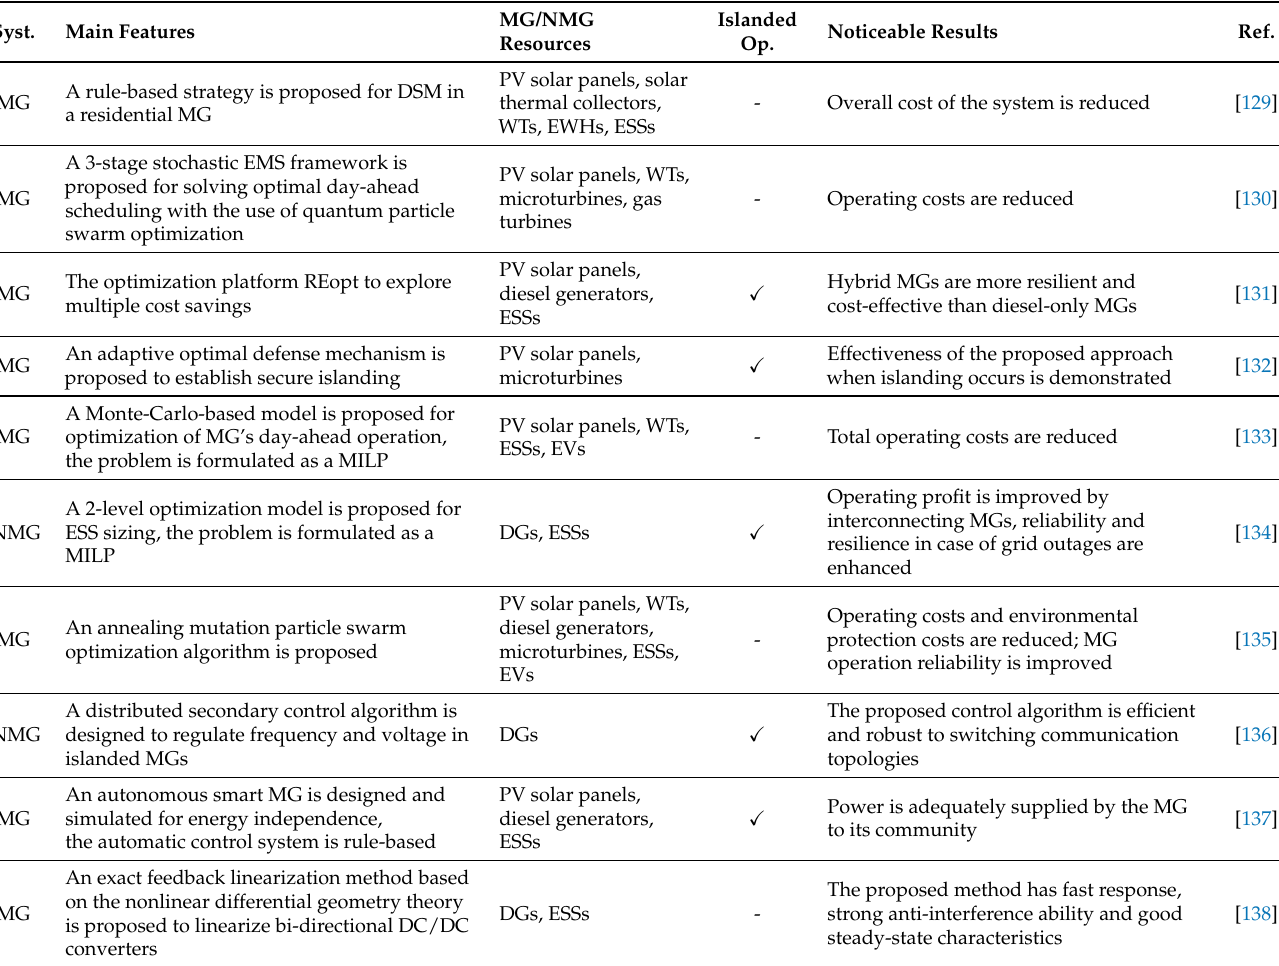
Table 10. A focus on significant papers dealing with other programming methods than the ones considered previously for MG/NMG management. DC stands for direct current. DG stands for distributed generator. DSM stands for demand side management. ESS stands for energy storage system. EWH stands for electric water heater. MG stands for microgrid. MILP stands for mixed- integer linear programming. NMG stands for networked microgrid. WT stands for wind